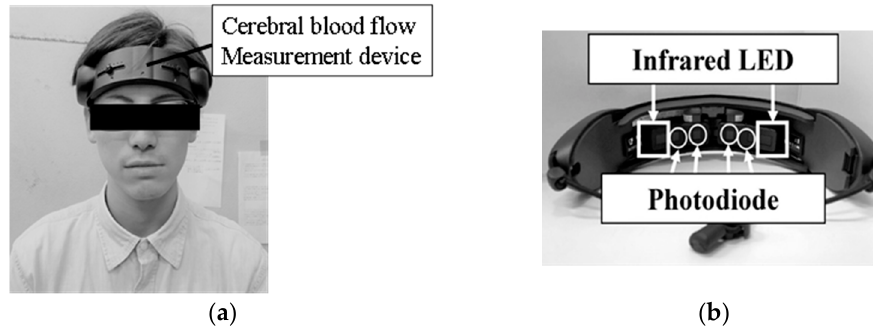
Figure 3. Cerebral blood flow measuring device. ( a ) Installation drawing; ( b ) Backside.